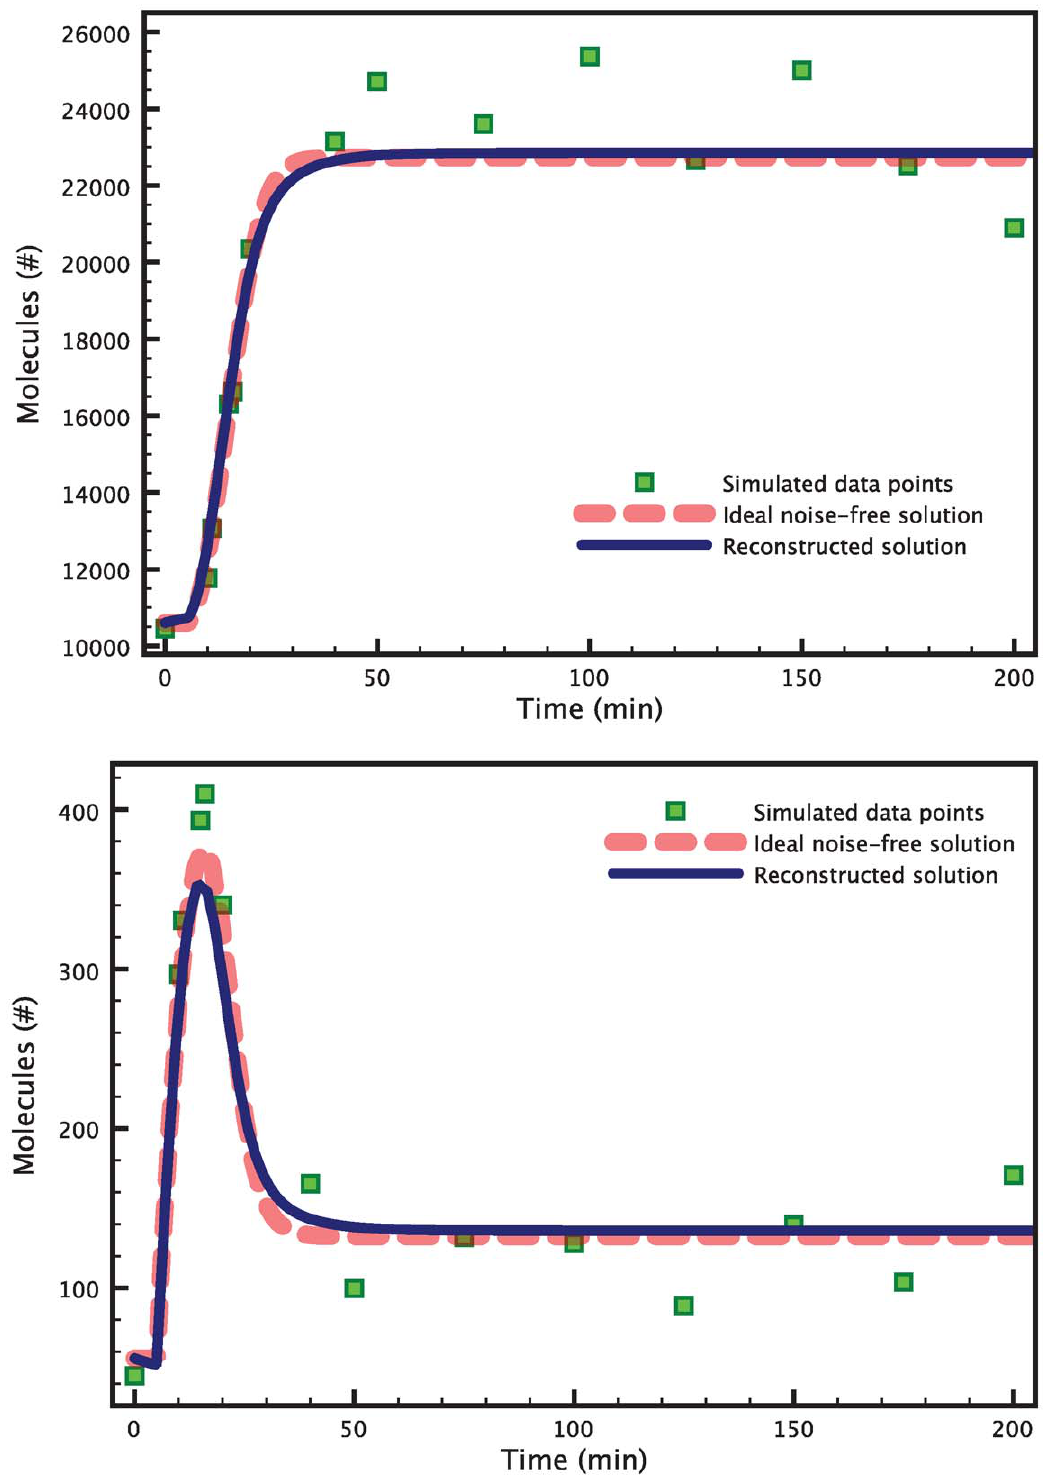
Figure 6. Estimation of 6 parameters in the heat shock model. The data points (green squares) are obtained by evaluating the true model solution (red dashed curve) at the chosen time points, and then adding white Gaussian noise. The blue solid line shows the reconstructed solution corresponding to the parameters estimates. Both the reconstructed measurement signal for D t (top) and the one for S t (bottom) are very close to the respective true solutions. The graphs are zoomed to highlight the transient response of the heat shock system after a temperature increase.